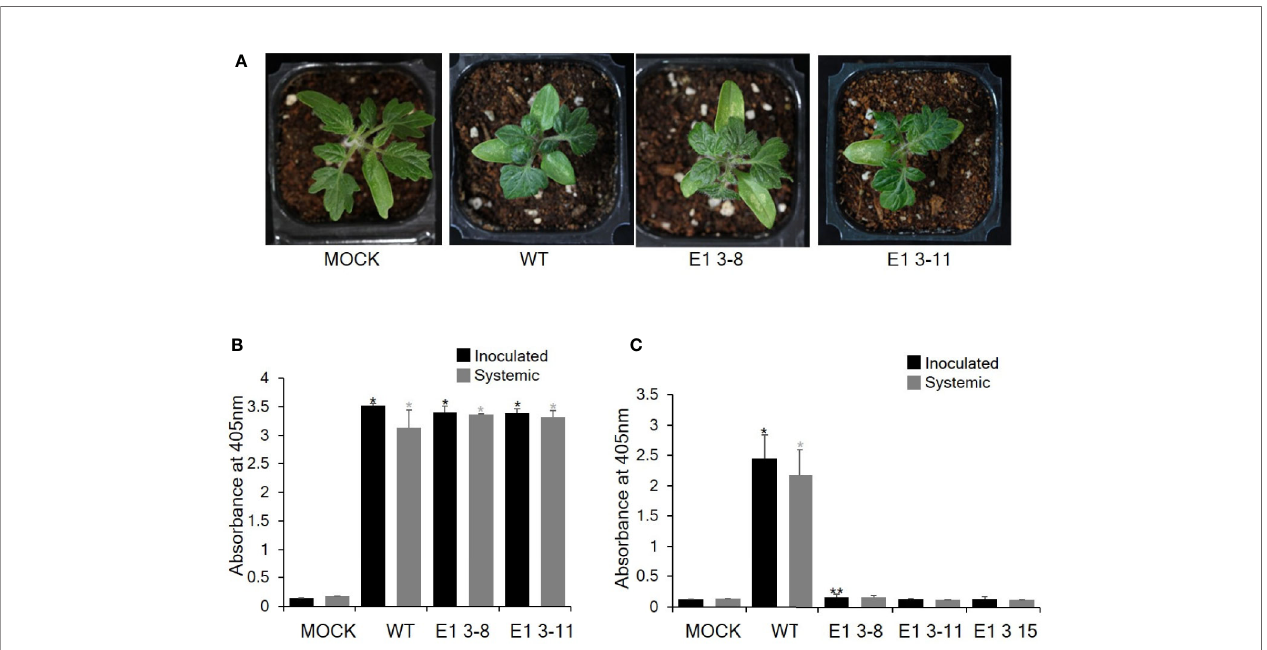
FIGURE 5 | Resistance analysis of eIF4E1 mutant lines challenged with potyviruses. (A) Phenotypes of eIF4E1 mutant lines infected with TEV at 7 DPI. (B, C) Analysis of the accumulation of TEV-HAT (B) and PepMoV (C) in inoculated and systemic leaves by DAS-ELISA. Error bars indicate mean values of replicates ± SD. Asterisks indicate signi fi cant differences (*P < 0.01; **P < 0.05) between ‘ mock ′ and ‘ treatments ′ according to Student ’ s t ‐